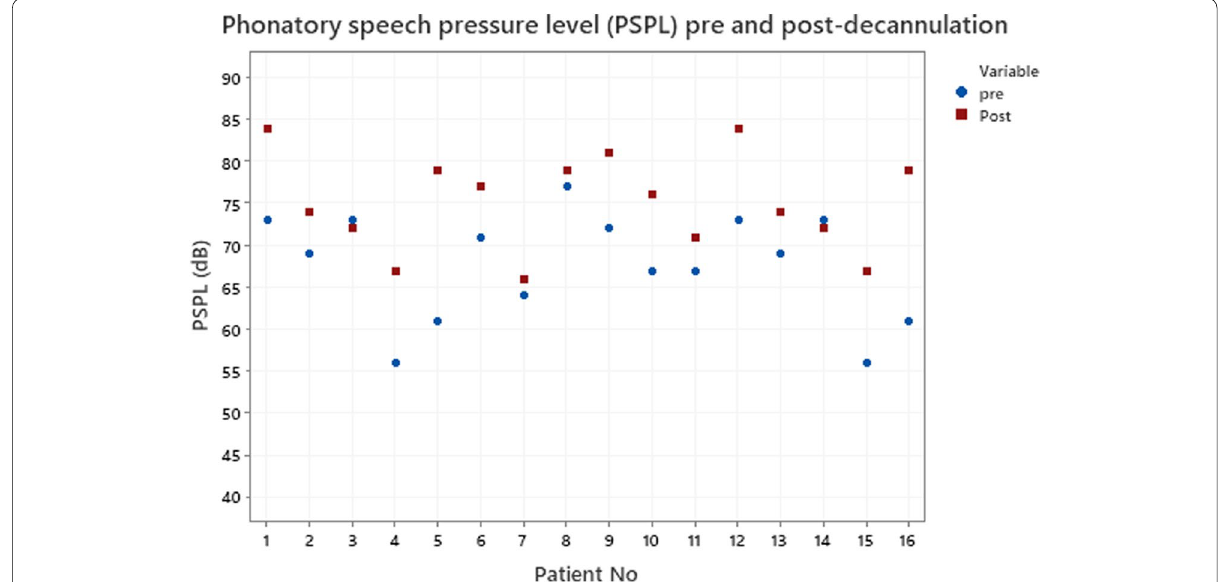
Fig. 5 Plot distribution of phonatory speech pressure level in all studied subjects before and after decannulation